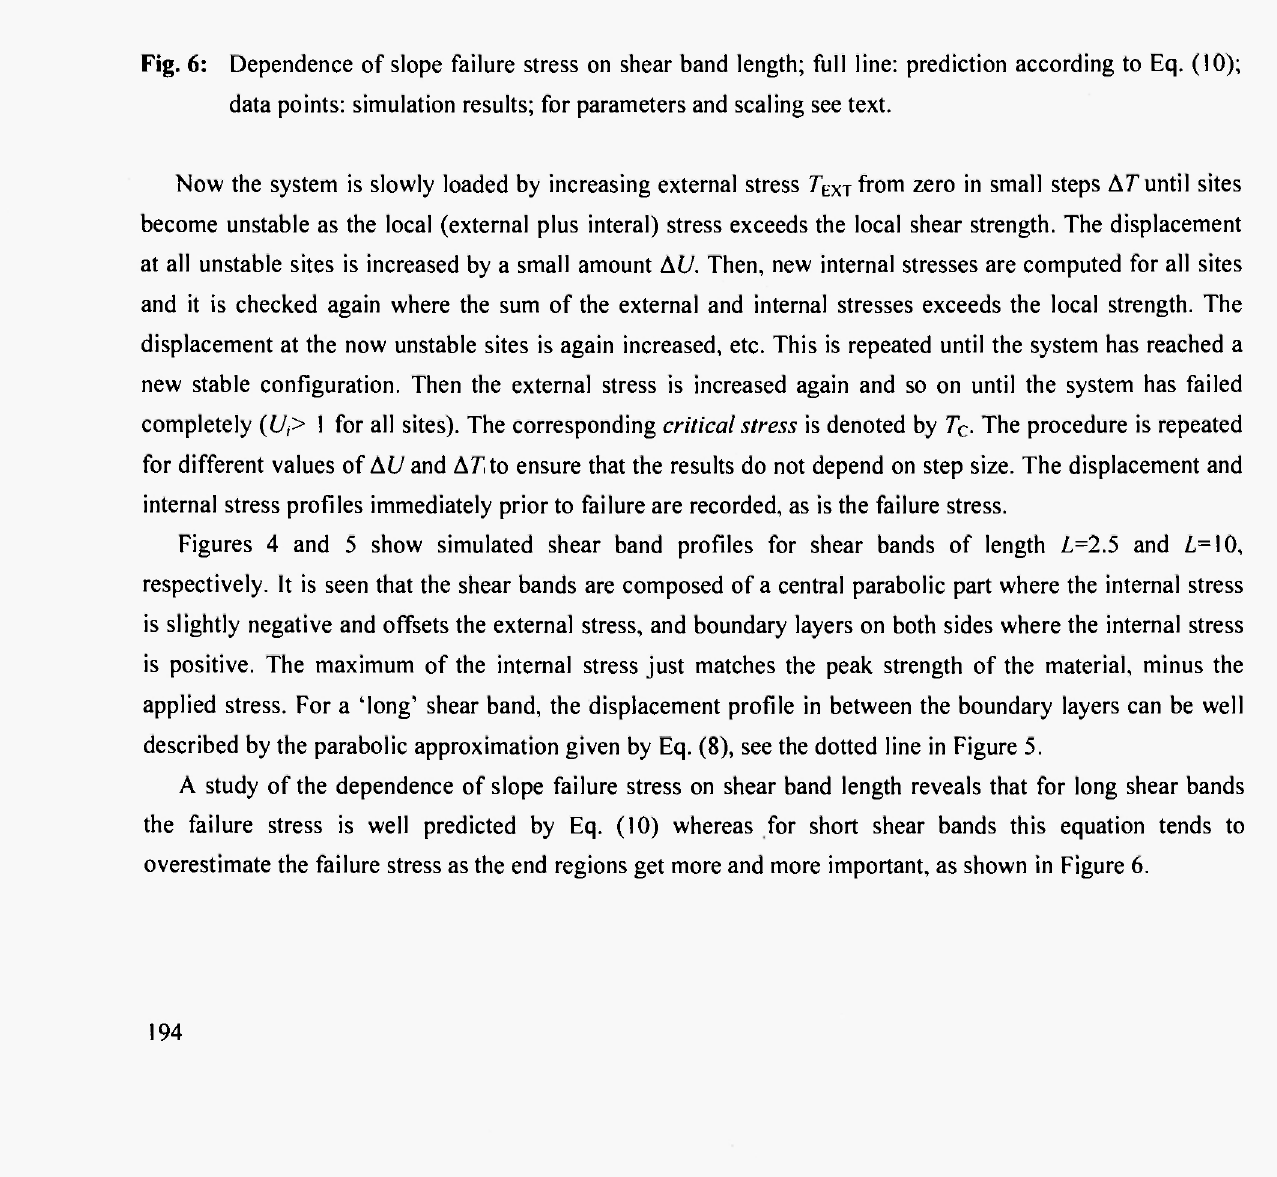
Fig. 6: Dependence of slope failure stress on shear band length; full line: prediction according to Eq. (10); data points: simulation results; for parameters and scaling see